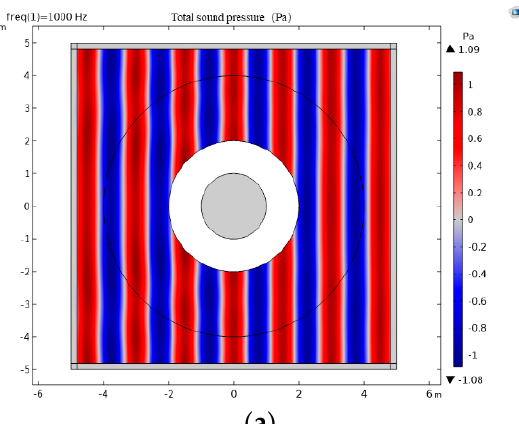
Figure 3. ( a ) Acoustic pressure distribution of external waters and ( b ) mechanical energy flow distribution inside the cloak at 1kHz incident sound frequency.